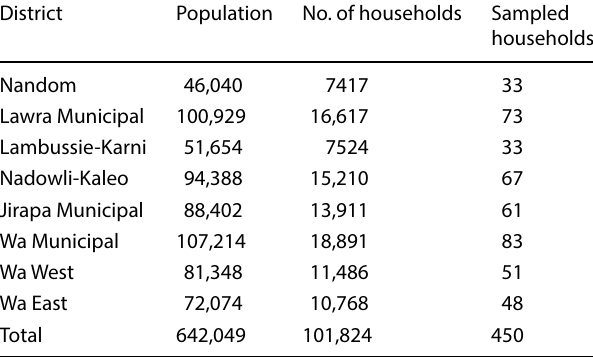
Table 1 Sample size by district